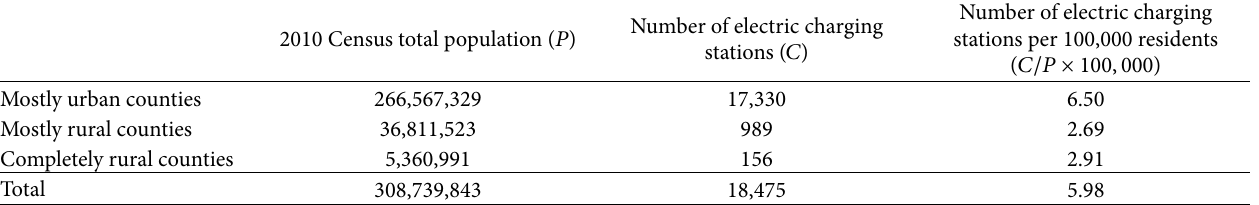
Table 1: Number of electric charging stations per 100,000 residents at urban and rural counties in the